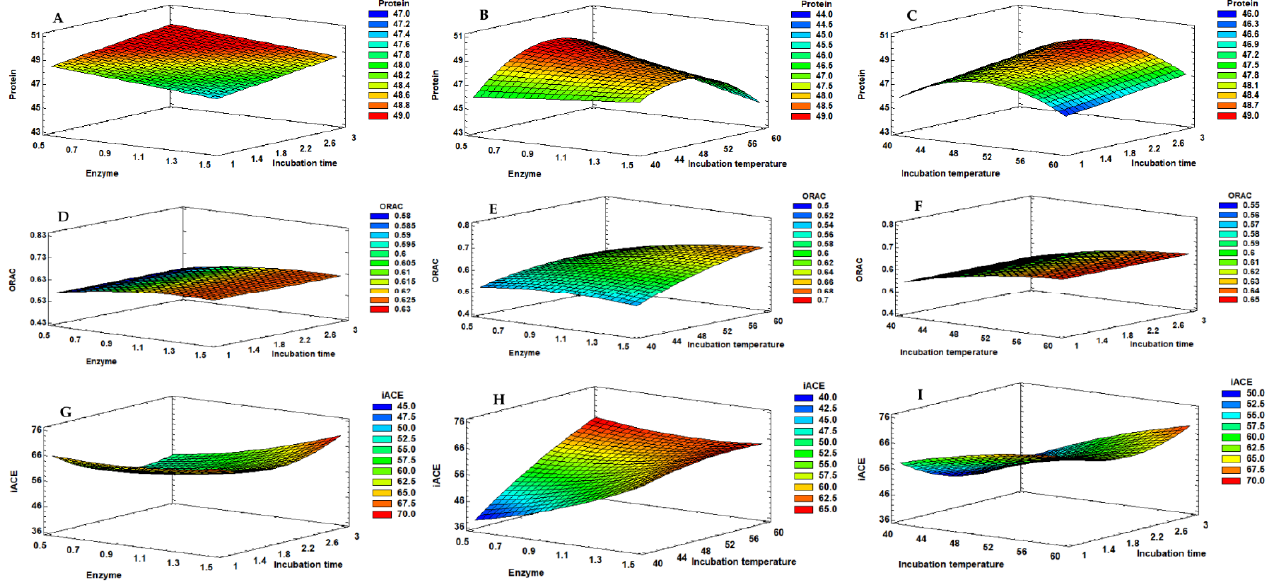
Figure 2. Response surface graphs corresponding to the combined effect of enzyme % (X A ), hydrolysis temperature (X B ) and hydrolysis time (X C ), on the protein ( A – C ), ORAC ( D – F ) and iACE ( G – I ) responses obtained for the mussel extracts produced with subtilisin. Table 2. Analysis of variance (ANOVA) for protein % obtained for the subtilisin Box-Behken design. Model Sum of Squares DF Mean Square F Value p -Value X A (Enzyme %) 4.7524